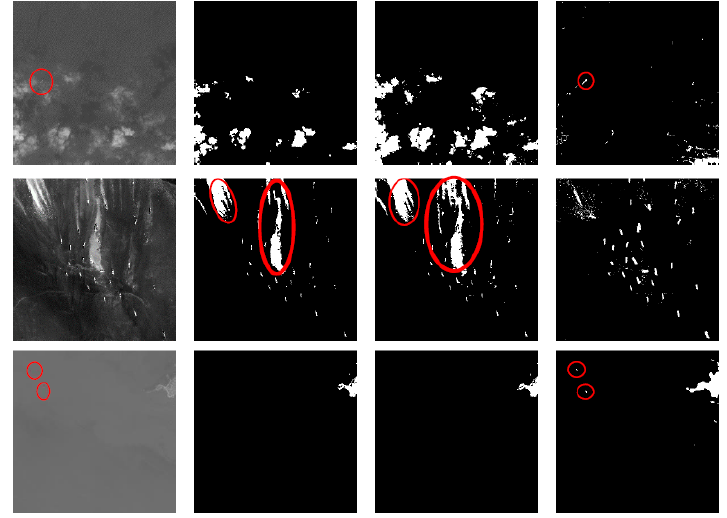
Figure 7. The upper, middle, and lower rows are the results of abnormal detection of cloud (or mist) coverage, relatively complicated sea conditions, and low contrast of the ship. The first three columns from left to right represent the original image, iterative segmentation, and Otsu threshold segmentation, respectively, and the last column represents the anomaly detection results of the multivariate Gaussian distribution used in this